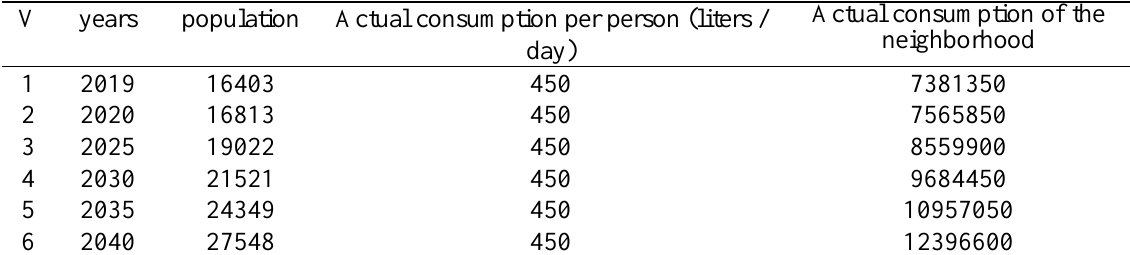
Table 8. Predicting the rate of daily water consumption / Al-Amir neighborhood / Source: